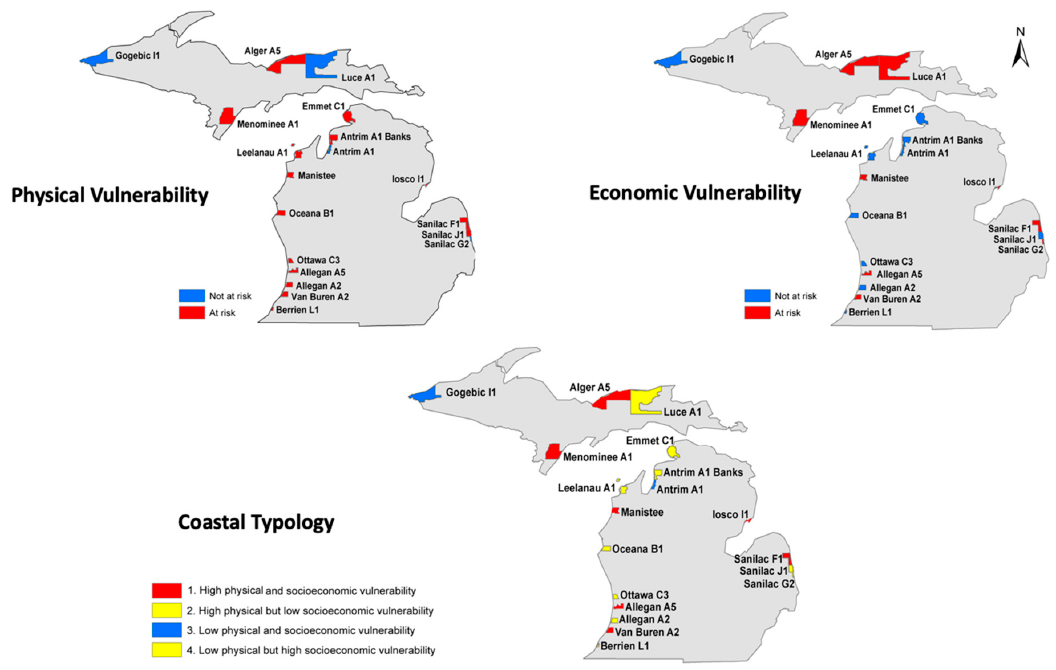
Figure 6. Physical and Socioeconomic Vulnerability from 2014–2018. Note: The colors are designed to match the typology in Figure 3. Table 2. Change Trajectory of Typology.